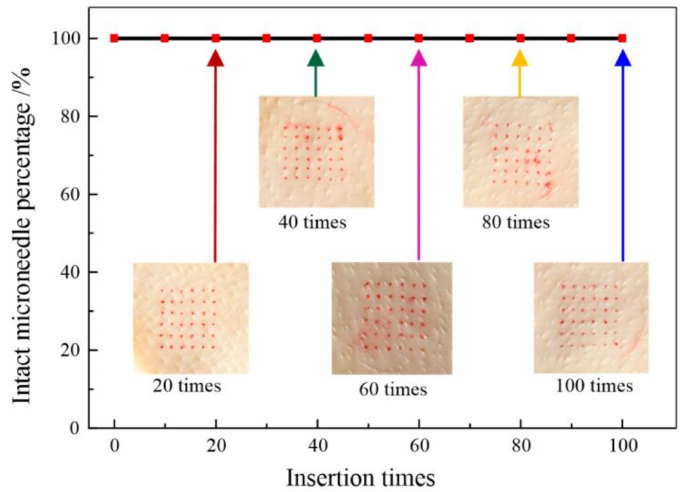
Figure 5. Relationship between intact microneedle percentage and insertion times.